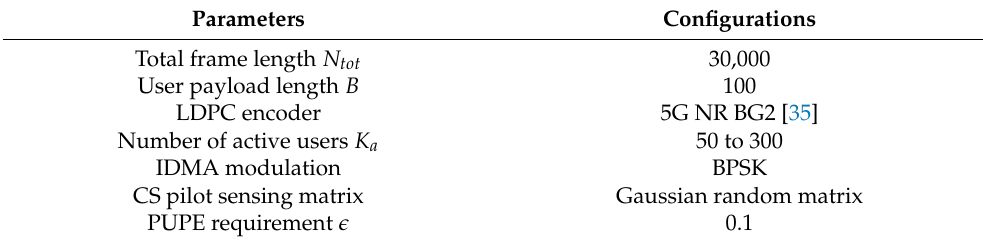
PUPE requirement (cid:101) 0.1